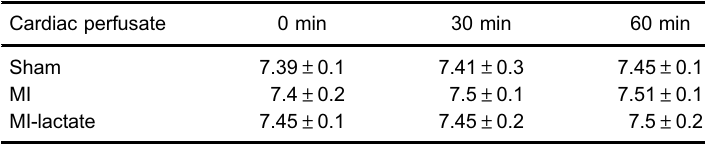
Table 2. pH values of perfusate during 60 min of perfusion with KH or KHL. Cardiac